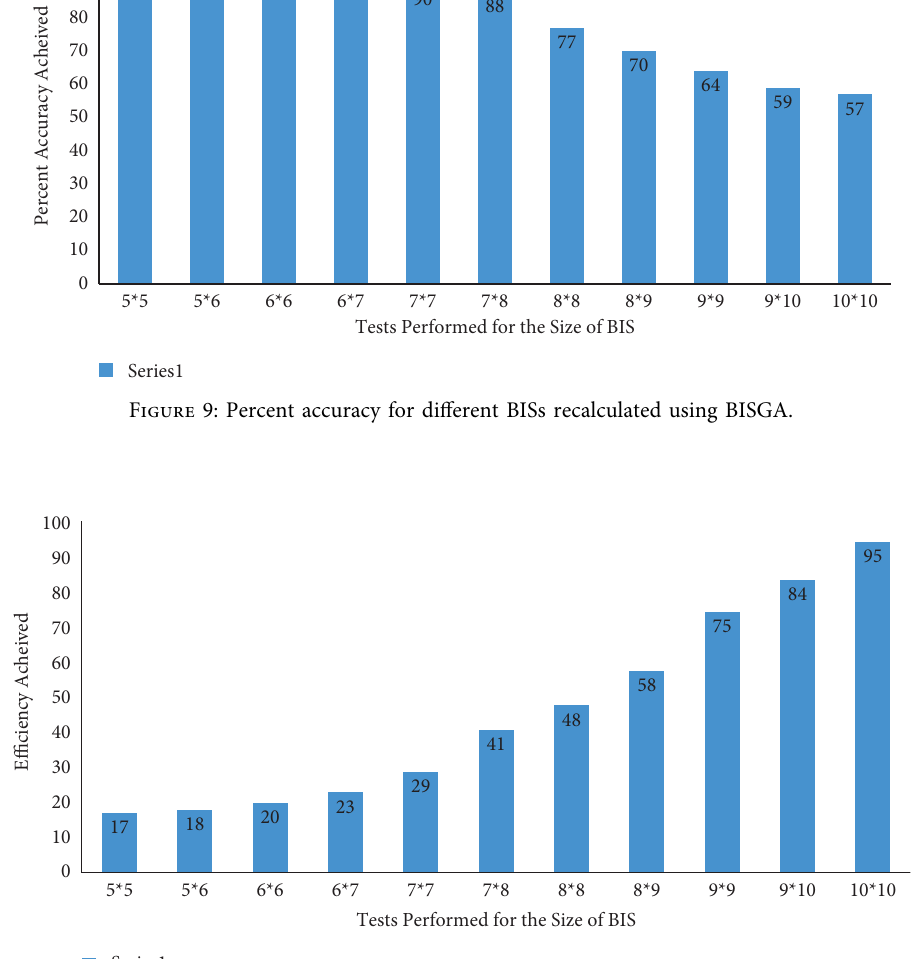
Figure 10: Efciency for diferent BISs recalculated using BISGA; the number represents the number of generations in which the solution was